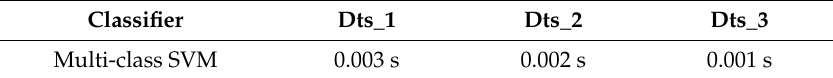
Table 19. Training and testing results for multi-class